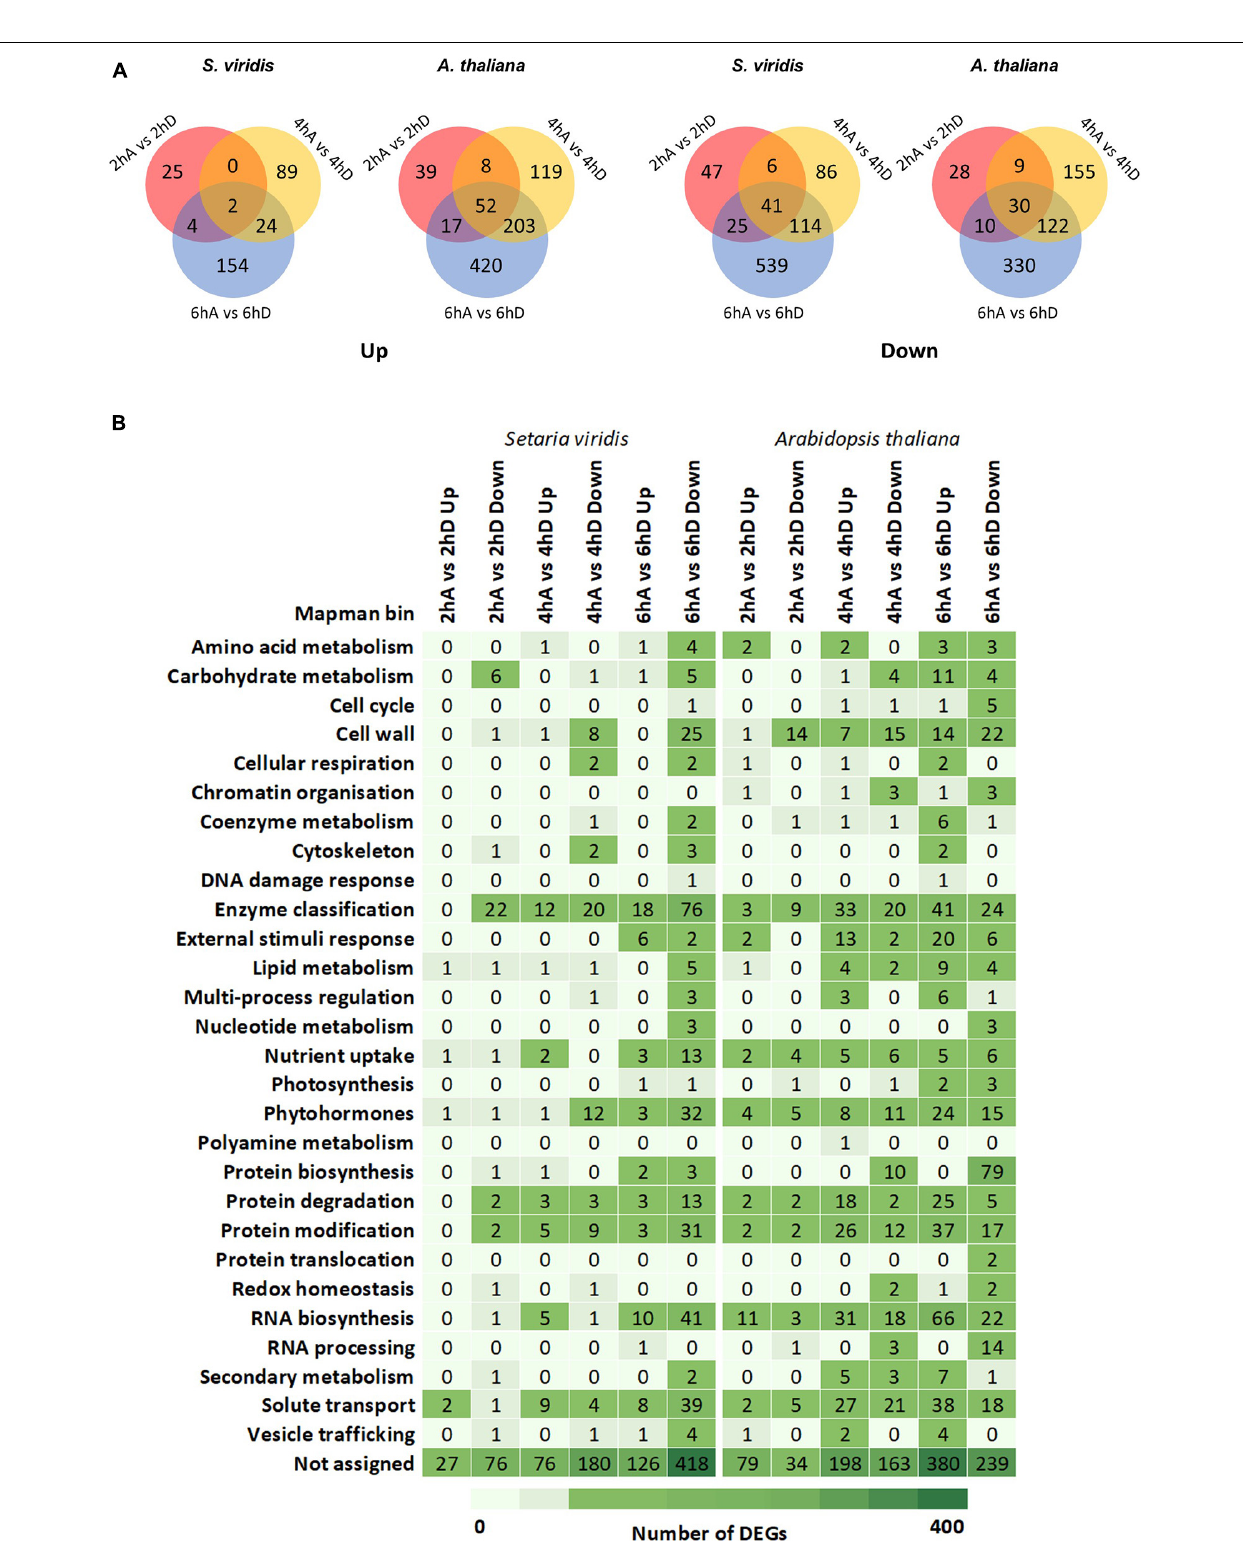
Frontiers in Plant Science |